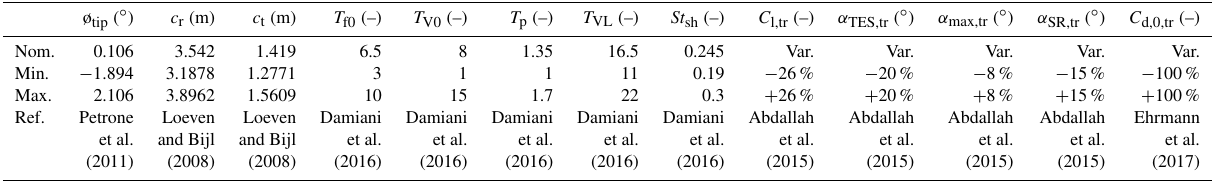
Table 9. Parameter value ranges of turbine blade aerodynamic parameters.